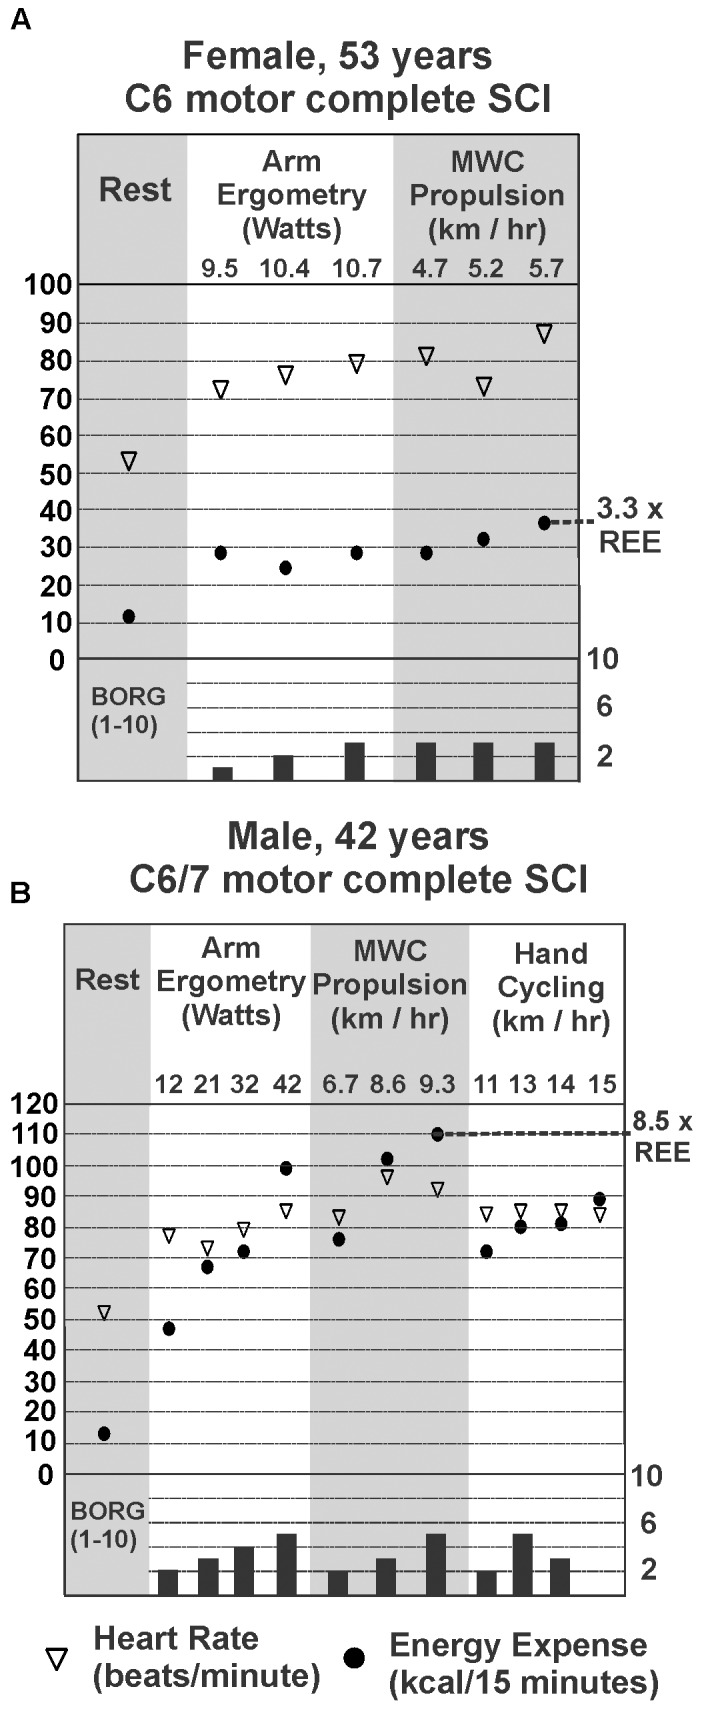
Steady-state energy expenditure (EE) and heart rate (HR) measured at rest (REE; gray panel on left) for a female (A) and male (B) with motor complete tetraplegia. EE, HR, and Borg rating of perceived exertion for each mode and intensity of exercise measured is shown in panels to the right of resting values. The highest steady state EE measured during exercise for each person is marked by the dotted line and expressed as a multiple of his or her resting EE.